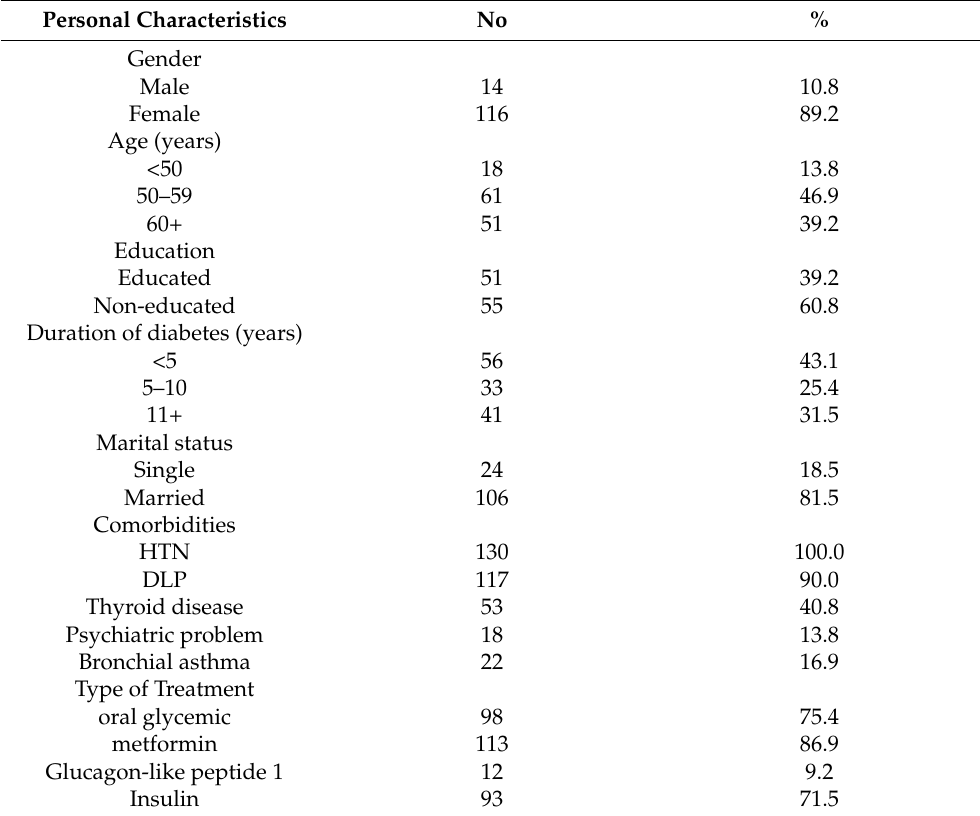
Table 1. Personal and sociodemographic characteristics of